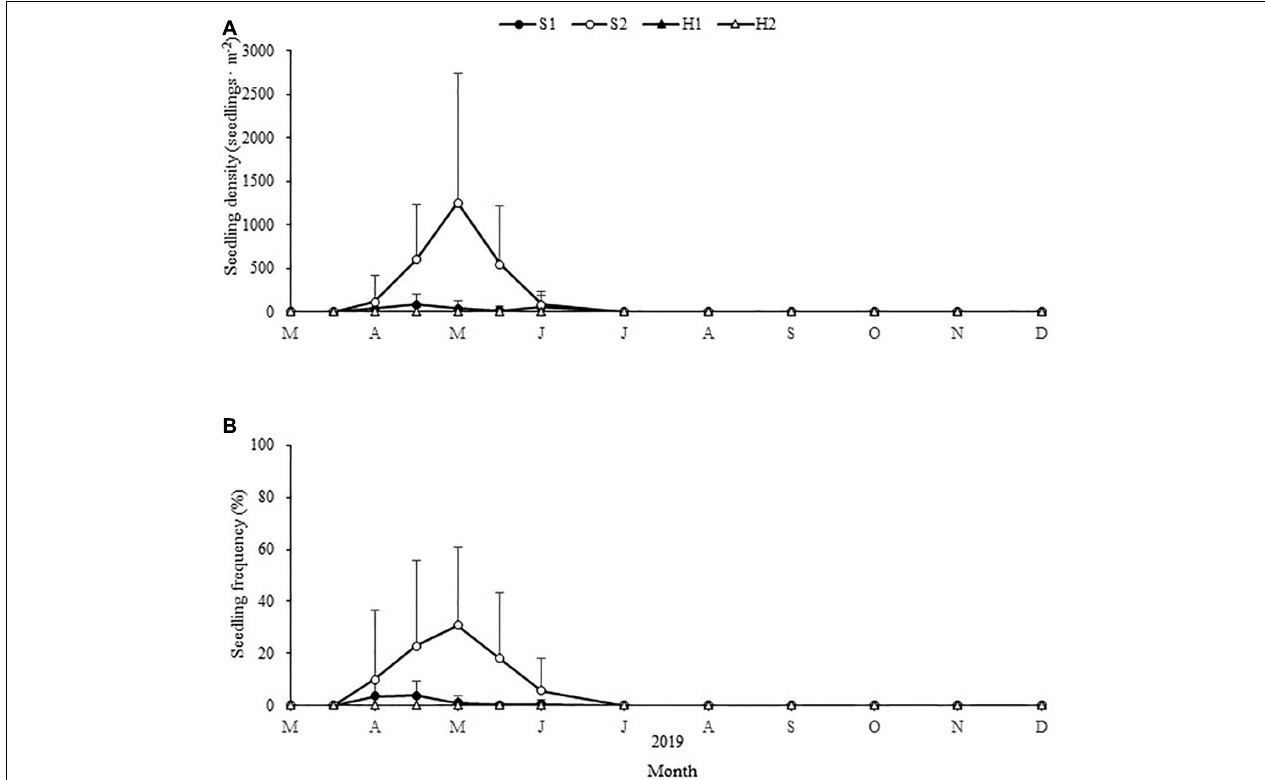
FIGURE 10 | Changes in Zostera japonica seedling densities (A) and seedling frequency (B) at the four study sites from March 2019 to December 2019. Values are mean ± SD ( N = 7 cores per